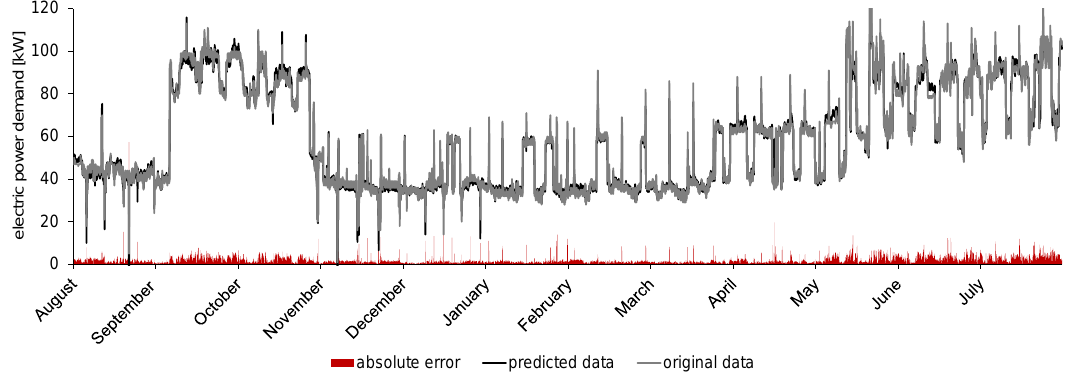
Figure 18. Time series plot of original and predicted electric power demand and resulting error predicted with linear regression (LR) algorithm.